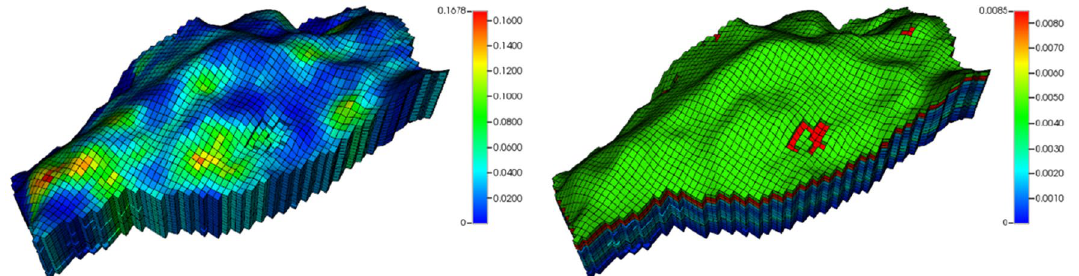
Fig. 3 PP C (left) and PP L (right)